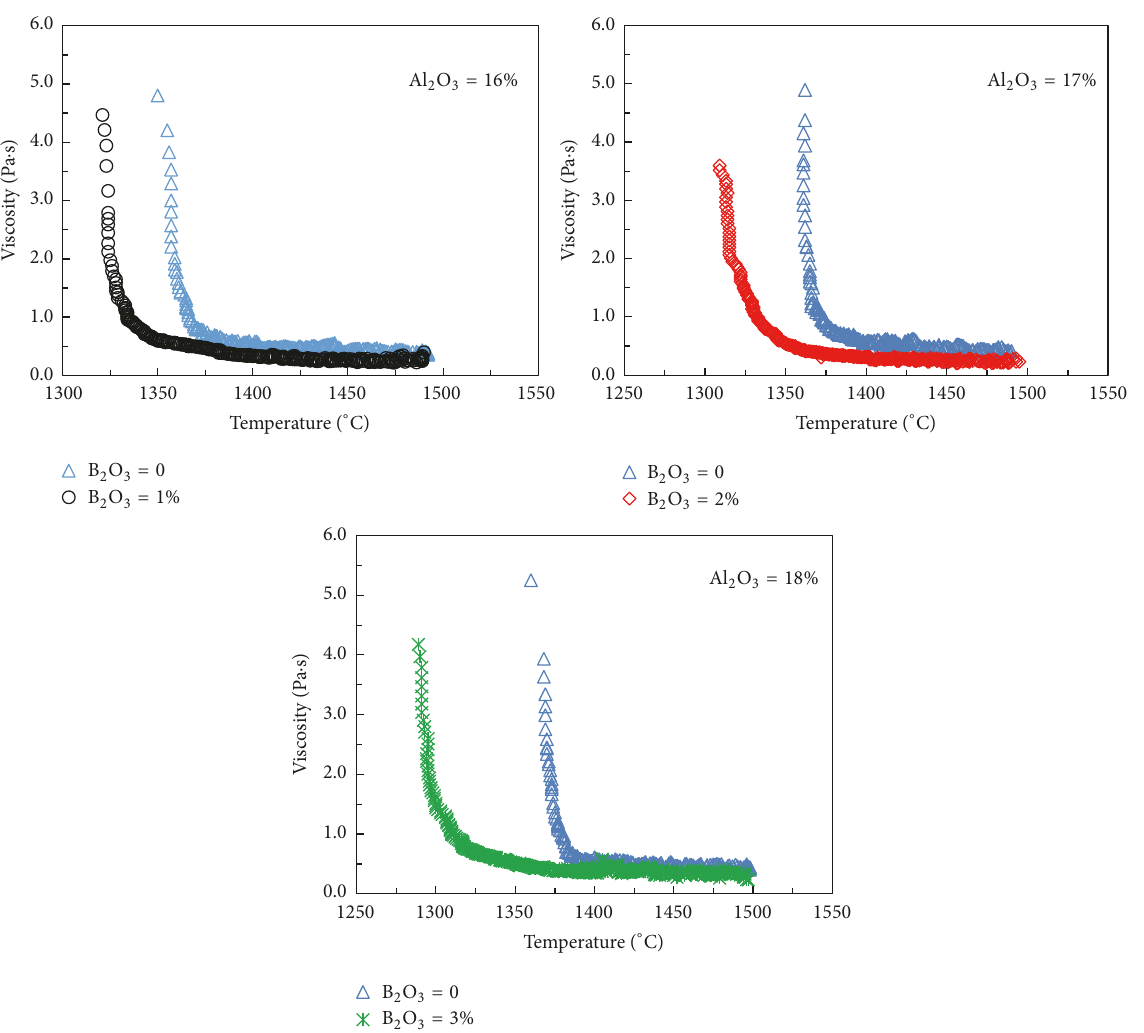
Figure 5: Viscosity changes of the slag with temperature at different B 2 O 3